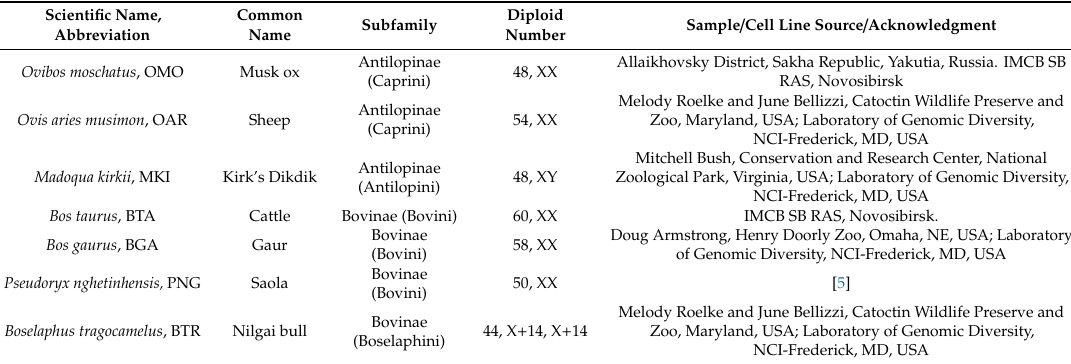
Table 1. The list of Bovidae cell lines used in this